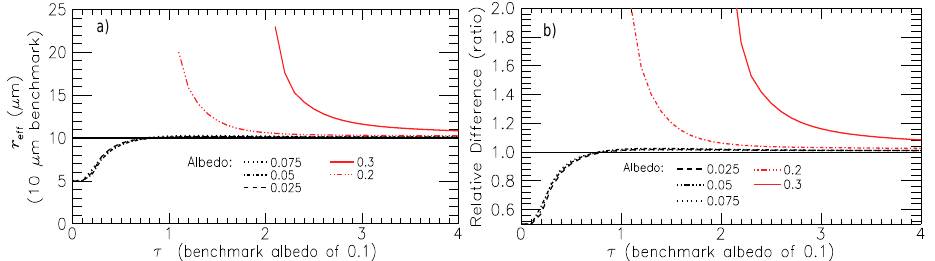
Fig. 9. (a) Absolute and (b) relative difference (ratio) between the result of a retrieval of r eff and the given values and a benchmark crystal size of 10µm derived by creating a cirrus with optical thicknesses between 0 and 4, a fixed surface albedo of 0.1 and the same retrieval assuming a surface albedo of 0.025, 0.05, 0.075, 0.2 and